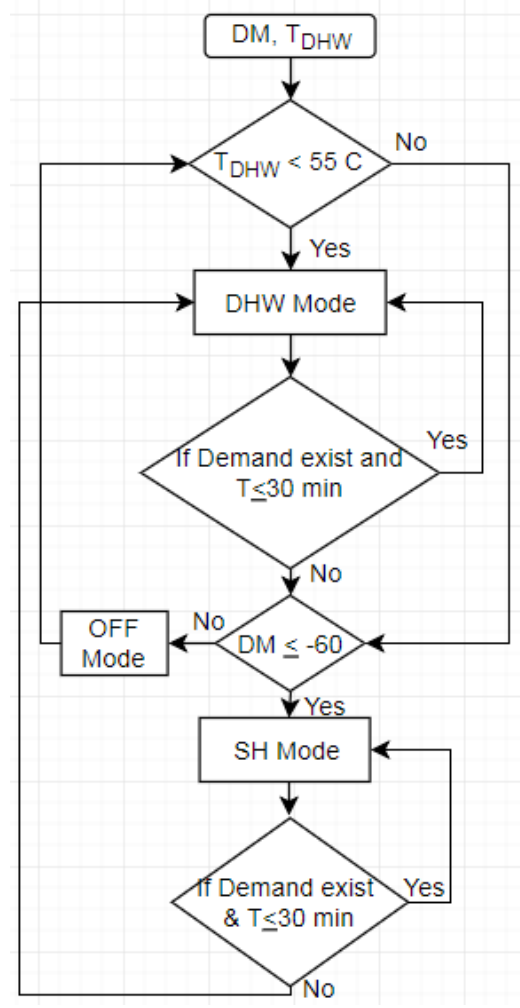
Figure 5. Operation of the control system in a flowchart. Figure 6. Operation of the control system in a